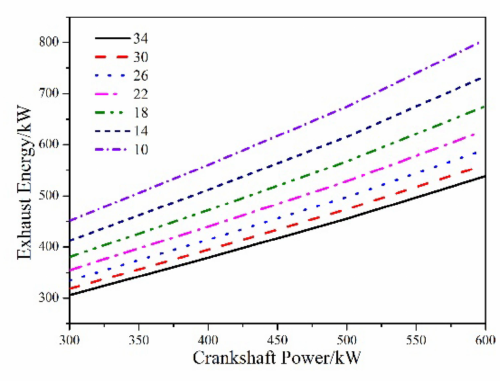
Figure 11. Variation of exhaust energy with load.